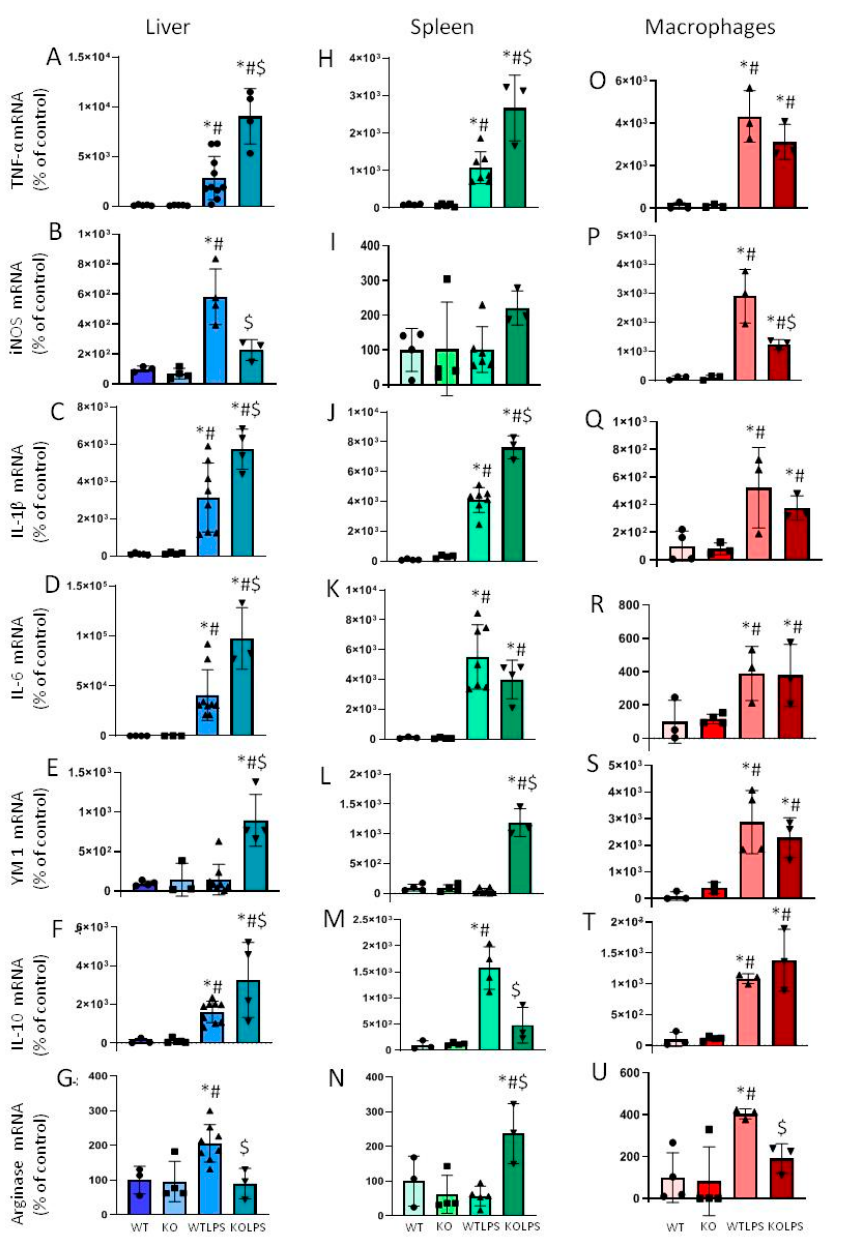
Figure 6. Effect of Gal3 deletion on the expression of TNF- α , iNOS , IL-1 β , IL-6 , YM1 , IL-10 , and arginase mRNAs in the liver, spleen, and macrophages of mice from the different treatments assayed, measured by RT-PCR ( A – U ). Animals were culled 1 h after LPS/saline injection. Results are mean ± SD of N = 3–10 animals, normalized to β -actin and expressed as relative expression to the WT group. Statistical significance (one-way ANOVA followed by the LSD post hoc test for multiple comparisons): *—compared with WT group; #—compared with KO group; $—compared with WTLPS group; p < 0.001 for ( A – F , H , J – M , O , P , T ); p < 0.01 for ( G , N , S ); p < 0.05 for ( Q , R , U ). Abbreviations: WT, wild type mice; KO, Gal3 knockout mice; WTLPS, wild type mice treated with LPS; KOLPS, Gal3 knockout mice treated with